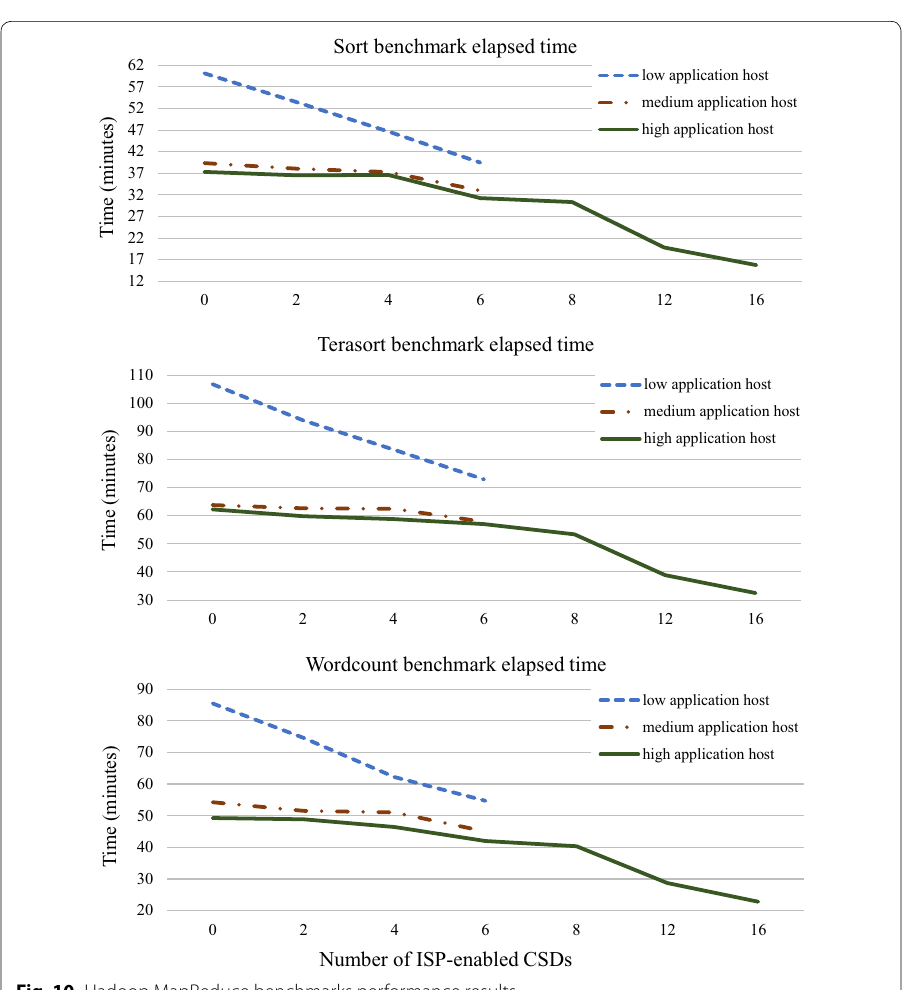
Fig. 10 Hadoop MapReduce benchmarks performance